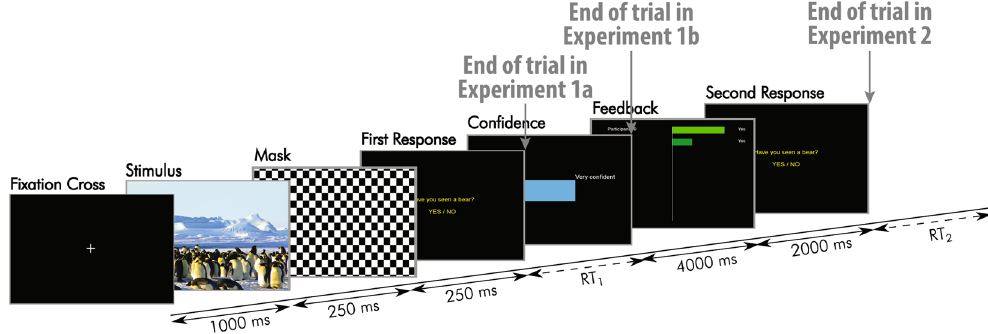
Figure 1. Timeline of a trial. The first four displays were common for all experiments, the fifth display was presented in Experiments 1b and 2, and the last two displays were only presented in Experiment